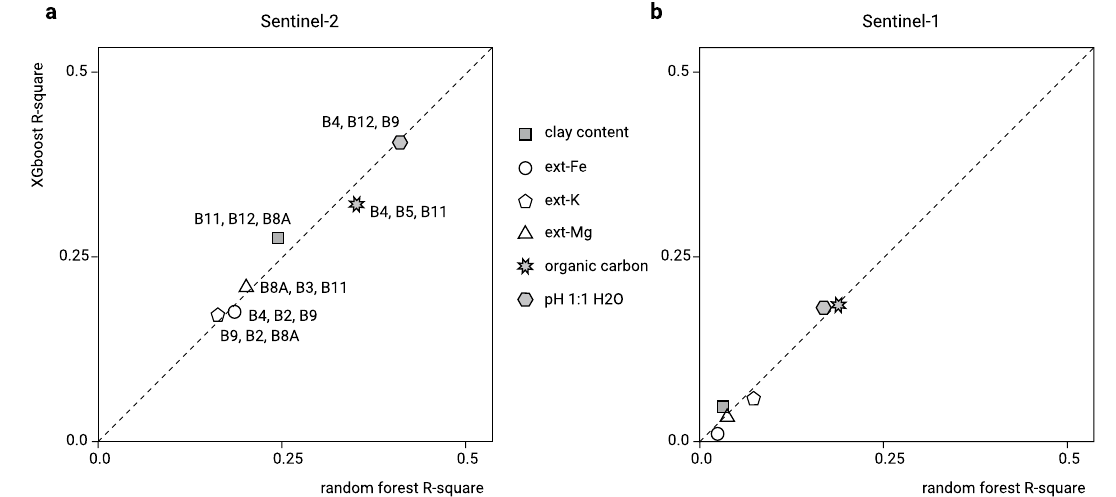
Figure 1. Preliminary predictive modeling R-square based on tenfold cross-validation and modeling selection of soil target variables purely as a function of Sentinel-2 ( a ) and Sentinel-1 ( b ) products. Derived by uploading soil data as points to Google Earth Engine, then overlaying with Sentinel-1/2 and Landsat products and fitting individual models using the caret package 1 (see also Fig.